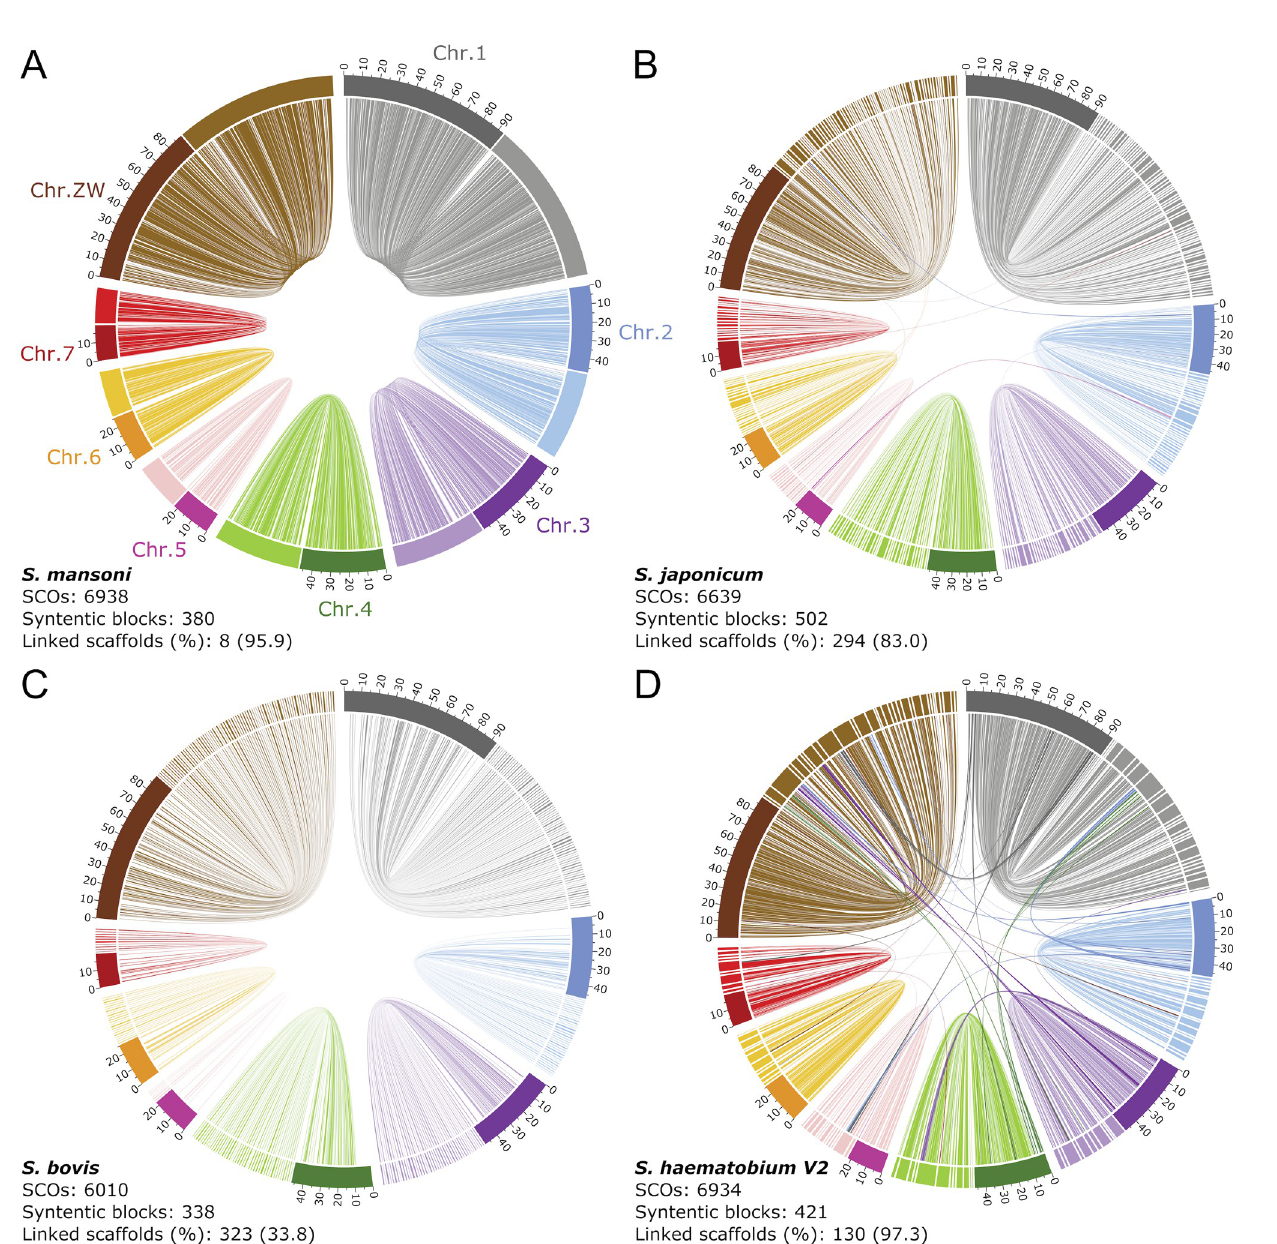
Fig 1. Synteny and contiguity of the Schistosoma haematobium reference genome. Comparisons are shown with genomes of A , S . mansoni , B , S . japonicum , C , S . bovis and D , the published draft genome of S . haematobium (Shae.V2). The eight chromosomes are represented as bars in a circular fashion, are distinctly- coloured in a dark shade and named according to the S . mansoni chromosomes. Syntenic blocks containing five or more single-copy orthologs (SCOs) between S . haematobium and the respective other species are shown as ‘links’ and are coloured, in a lighter shade, based on the link that spans the largest portion of the linked reference scaffold/chromosome. The number of SCOs, syntenic blocks, and linked scaffolds, as well as the percentage of the genome assembly that they represent are shown for each